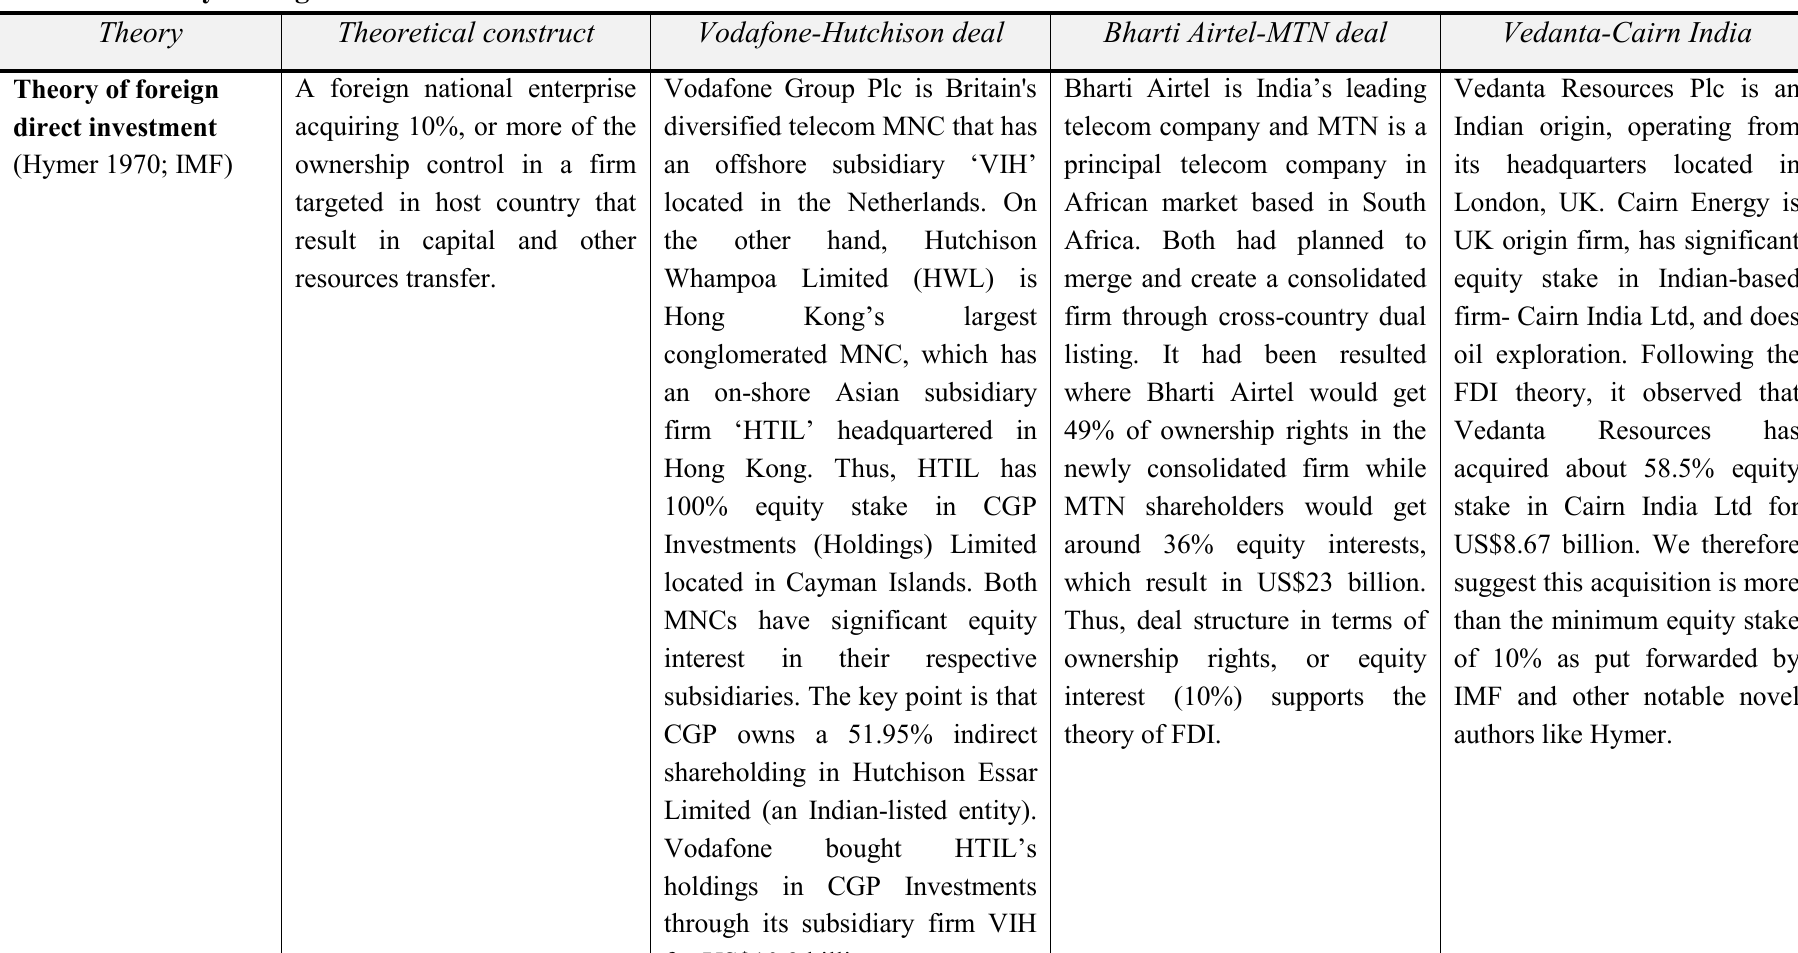
Table 1. Theory testing and case illustrations